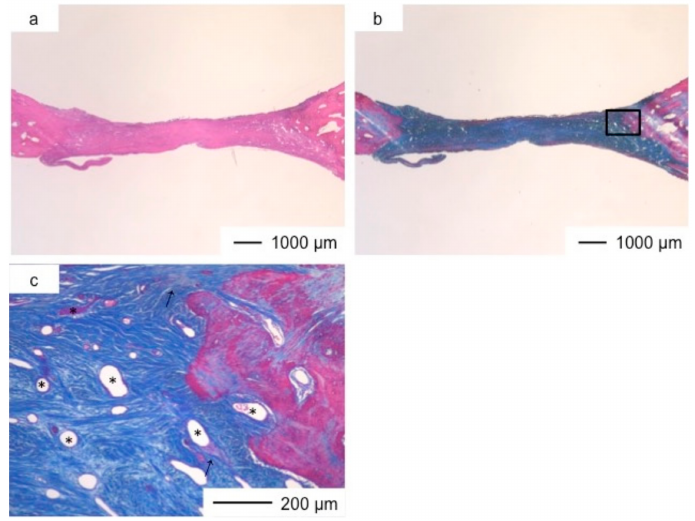
Figure 3. Light microscopic images of ChG in cranioplasty two years after implantation, stained by HE ( a ); and AM ( b ); ( c ) Magnification of the inset in ( b